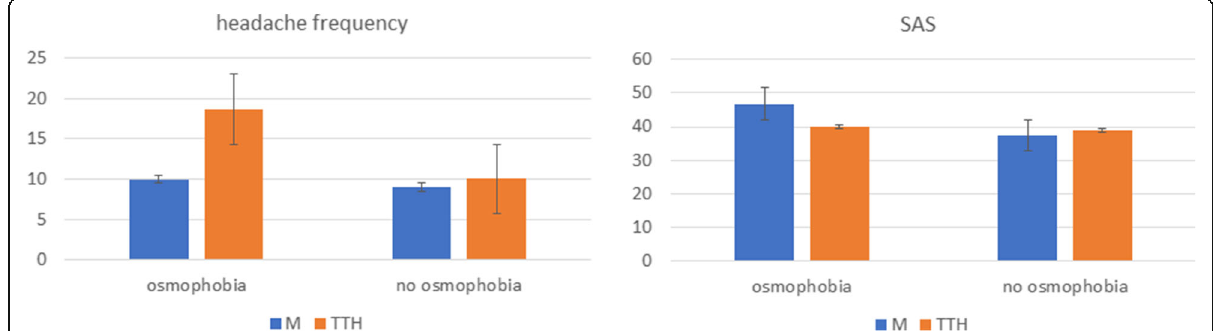
Fig. 3 Mean and Standard deviations of headache frequency and anxiety disorder in patients with osmophobia e without osmophobia